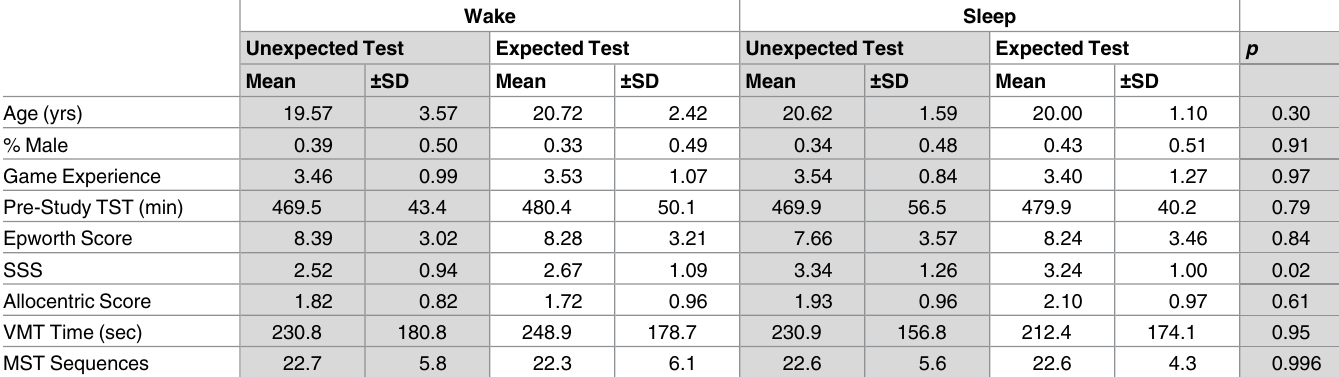
Table 1. Experimental Group Characteristics at